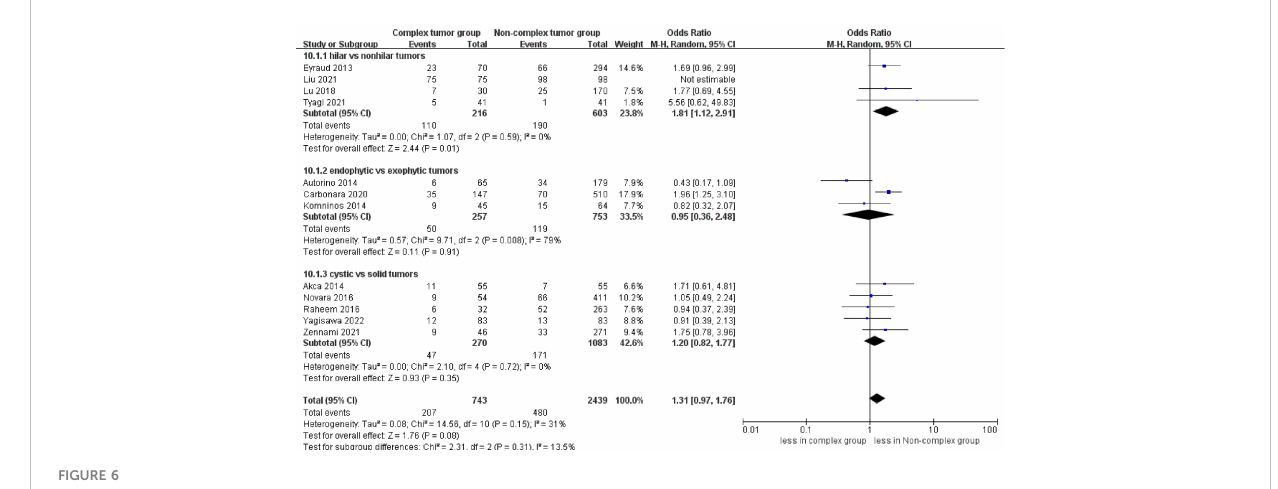
FIGURE 6 Forest plots of complication- overall complications.